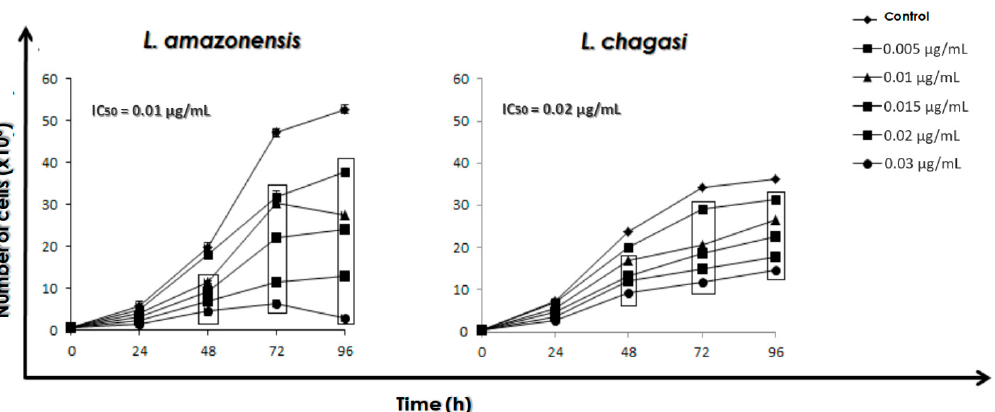
Figure A1. Effects of amphotericin B on the proliferation of promastigotes of L. amazonensis and L. chagasi . The growth rate of promastigotes was monitored when the parasites were cultured at 28 °C in the absence (control) or in the presence of different concentrations of amphotericin B. The number of viable cells was estimated daily up to 96 h in a Neubauer chamber, and calculated IC 50 values are indicated. Results represent mean ± standard deviation of three independent experiments performed in triplicate. Boxes highlight significant different values when compared to control ( p ˂ 0.05).